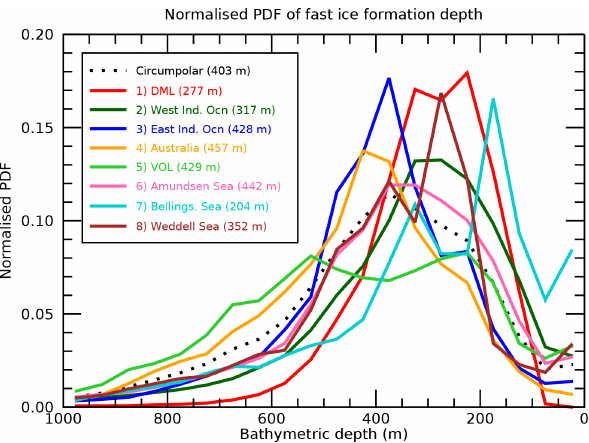
Figure C1. Normalised histograms of persistence-weighted fast-ice formation depth for the eight fast-ice regions. Mean formation depth for each region is indicated in the